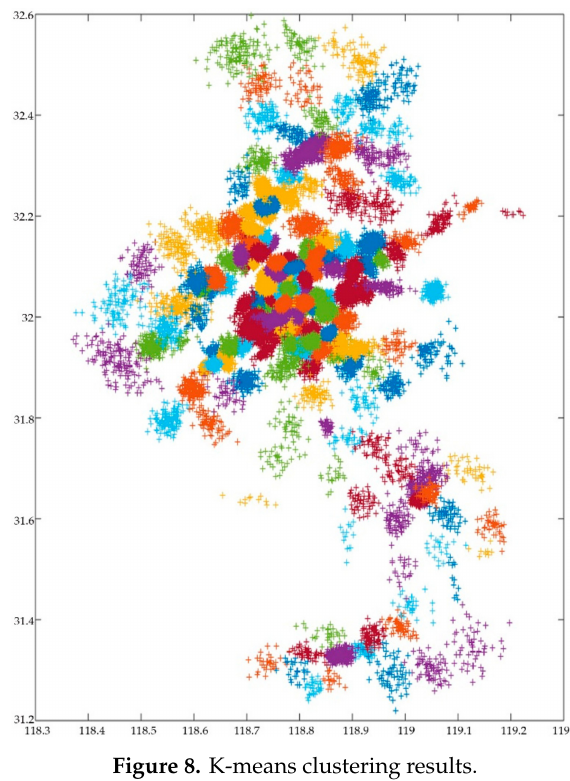
Figure 8. K-means clustering